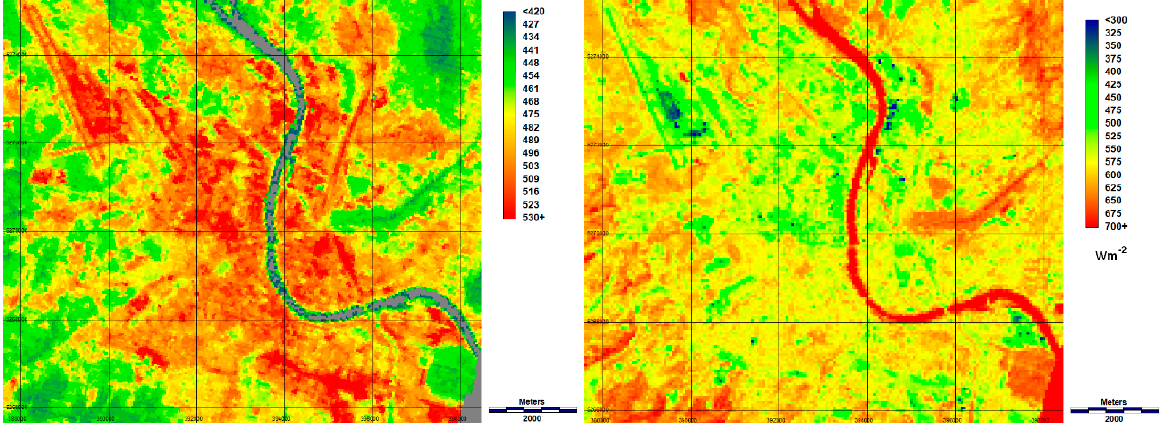
Figure 2. Longwave emission in Wm − 2 ( left ) and net radiation in Wm − 2 ( right ) from Landsat-ETM on 2 August 2002, in Basel, Switzerland, during the BUBBLE field campaign.